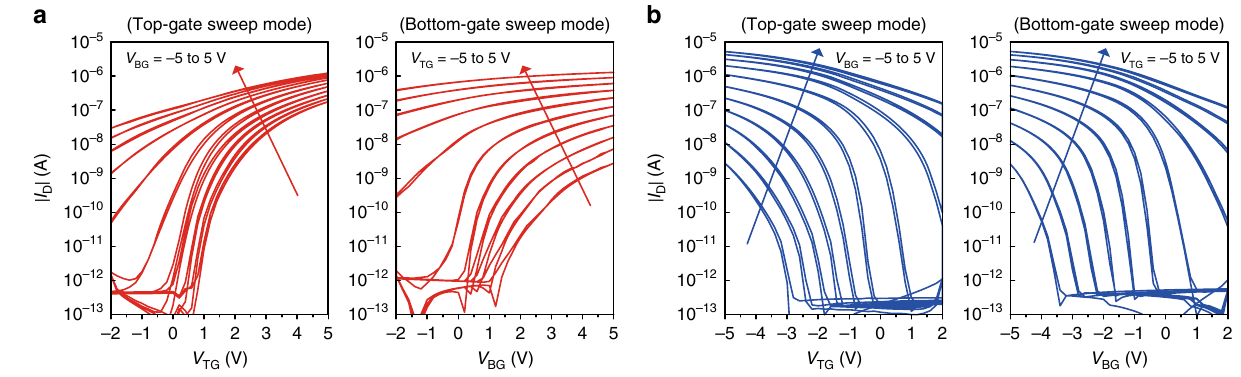
Fig. 4 Dual-gate complementary transistor operations. a Saturation transfer characteristics ( V DS = 5 V) of the n-type dual-gate transistor in top-gate (left) and bottom-gate (right) sweeping modes ( V TG : top-gate voltage, V BG : bottom-gate voltage). b Saturation transfer characteristics ( V DS = − 5 V) of the p-type dual-gate transistor in top-gate (left) and bottom-gate (right) modes